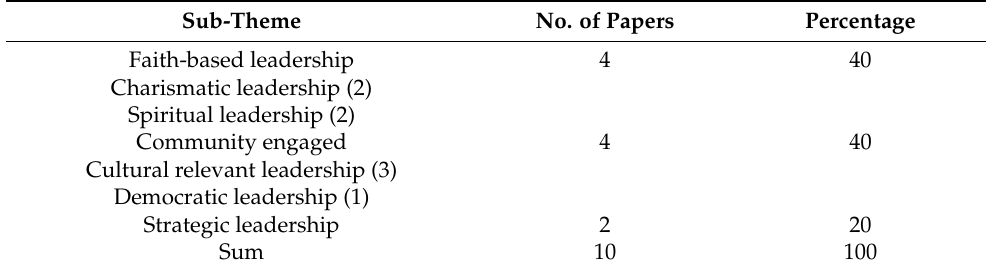
Table 4. Models of leadership